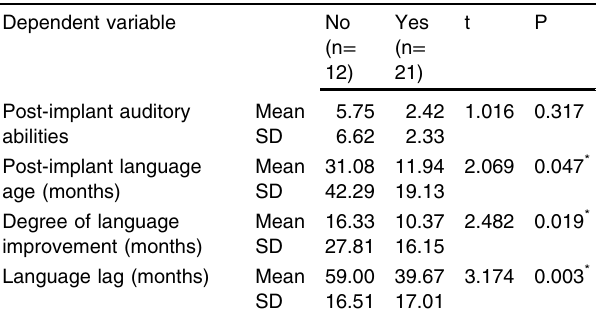
Table 5 Relationship between pre-implant receipt of language therapy and dependent